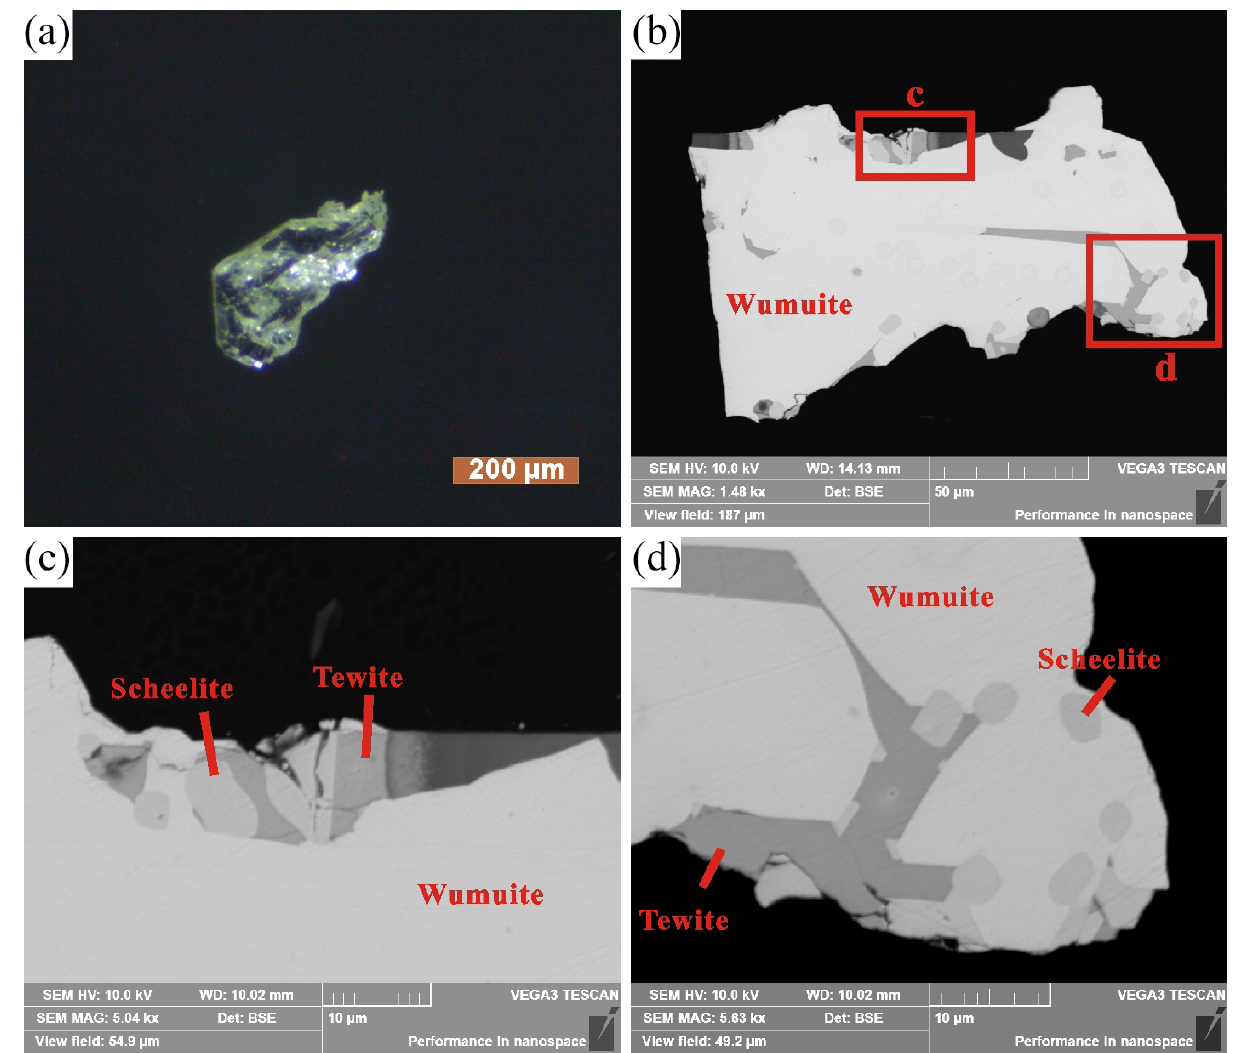
Figure 2. Backscattered electron (BSE) images of wumuite and some associated minerals.